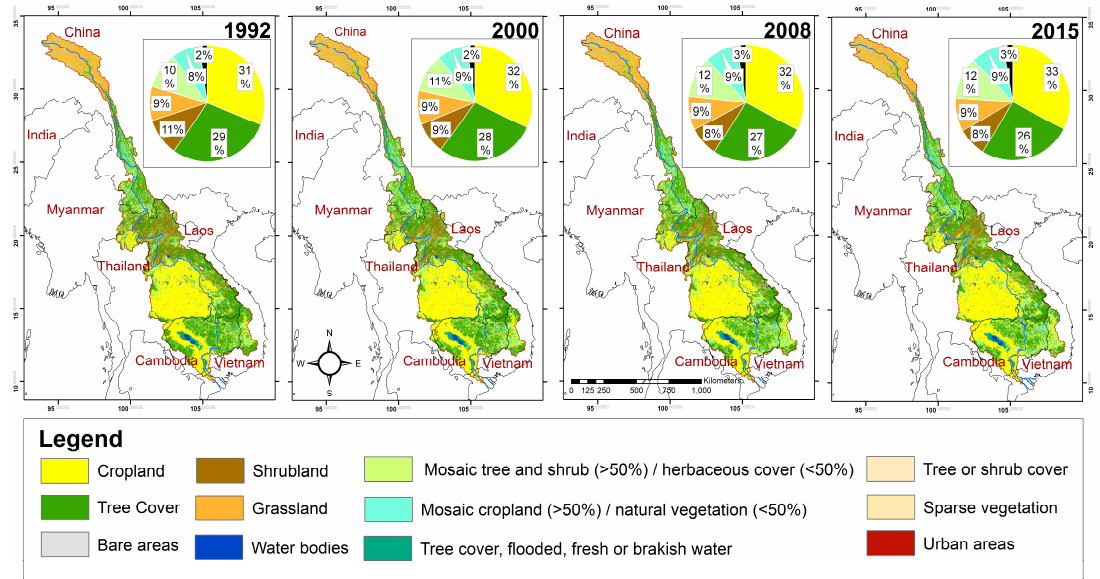
Figure 3. Major land use and land cover types for 1992, 2000, 2008, and 2015. The pie charts show the fraction of each land cover type with identical color coding as in the maps except for the black color that includes all other land cover types than those shown in the charts. Urban areas are not shown in pie charts as they represented only 0.06% of basin area in 1992 and increase slightly to 0.08, 0.15, and 0.27% in 2000, 2008, and 2015, respectively. Data source: European Space Agency-Climate Impact Initiative (ESA-CCI: https://www.esa-landcover-cci.org/, accessed on 27 January 2018).